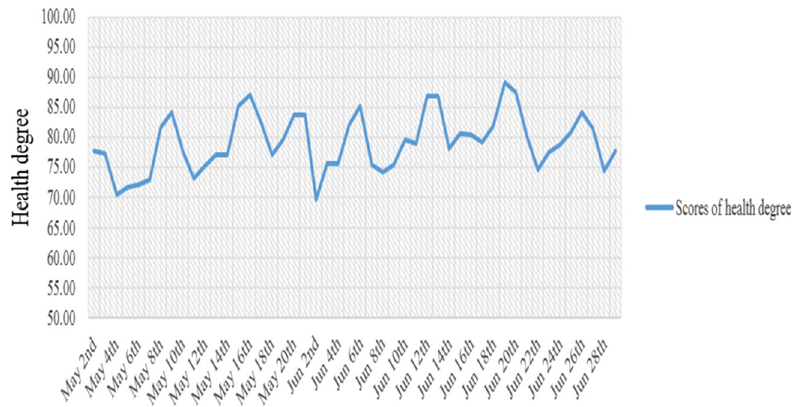
Fig. 6 Results of fuzzy comprehensive evaluation